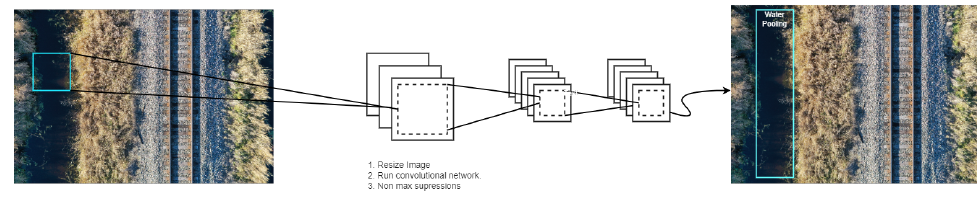
Figure 1. YOLO object